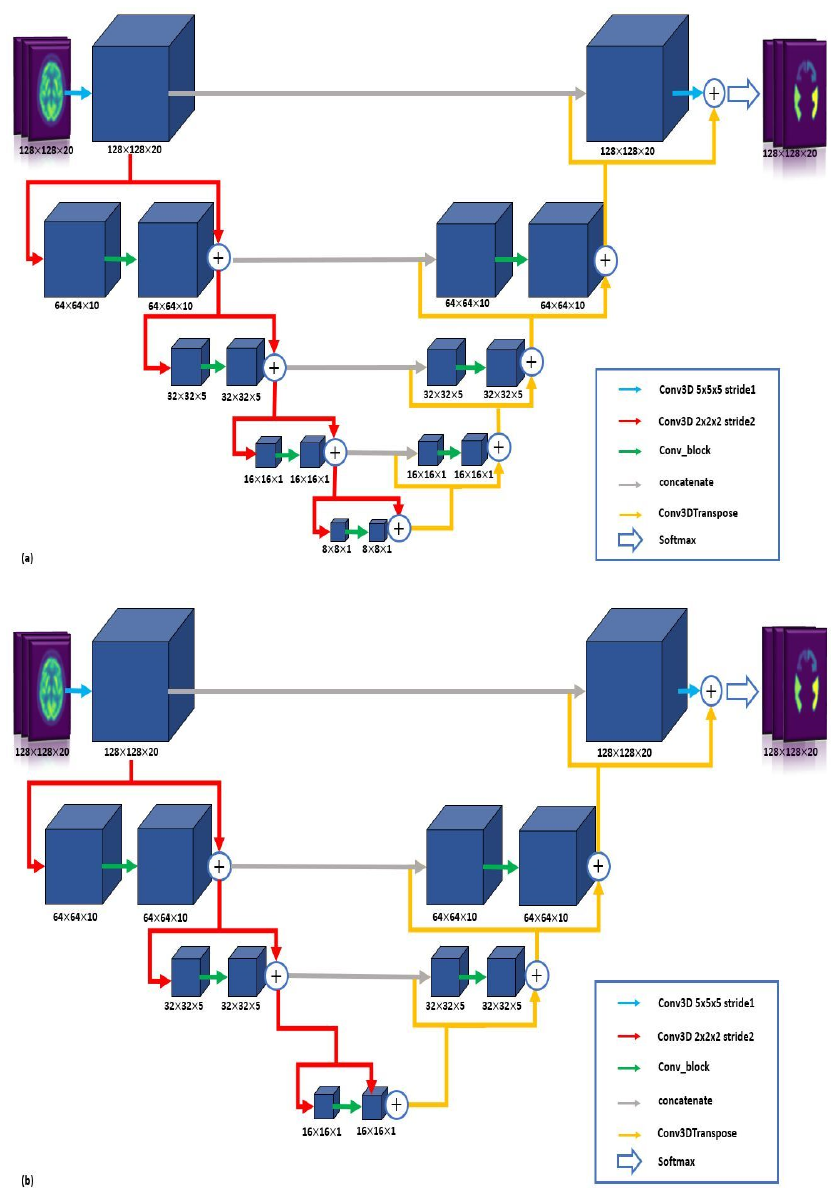
Figure 3. V-Net architectures: ( a ) V-Net, ( b ) V-Net-TwoLevel. The arrows correspond to operations or functions applied to the images; the blue cubes are the image volumes; numbers under the cubes are volume sizes.